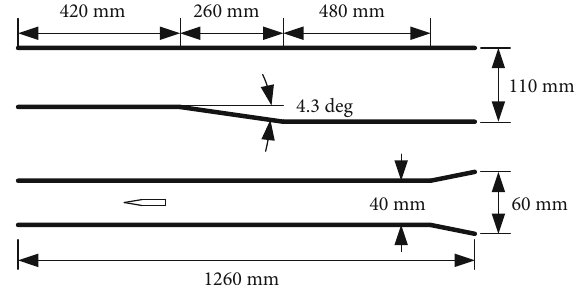
Figure 9: Geometry con fi guration of the supersonic combustor at HIT.